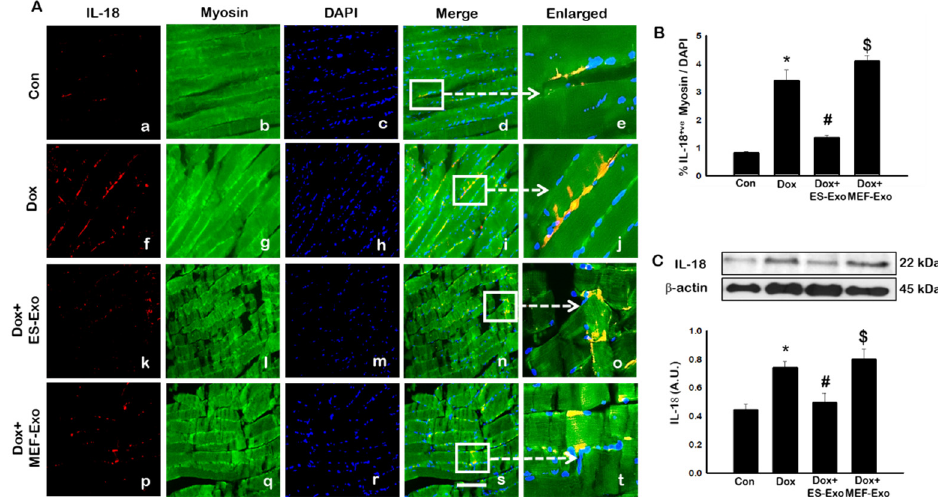
Figure 7. Treatment with ES-Exos reduces IL-18 secretion induced by Dox. ( A ) Representative photomicrographs of soleus muscle sections stained with myosin and pyroptotic marker, IL-18. Each box shows IL-18 + cells in red ( a , f , k , p ), myocytes in green ( b , g , l , q ), DAPI in blue ( c , h , m , r ), merged images ( d , i , n , s ), and enlarged areas of merged images ( e , j , o , t ). ( B ) Histograms from quantitative analysis of IL-18 + cells over total DAPI. ( C ) Representative blot and densitometric analysis of IL-18. Error bars = mean ± S.E.M. * p < 0.05 vs. control, # p < 0.05 vs. Dox, $ p = non-significant vs. Dox, one-way ANOVA followed by Tukey test; western blot quantities are represented as A.U. Scale bar = 100 µm, n = 14–16, male and female ( B ) and n = 6–8, male and female ( C ). Images taken at 40 × magnification.